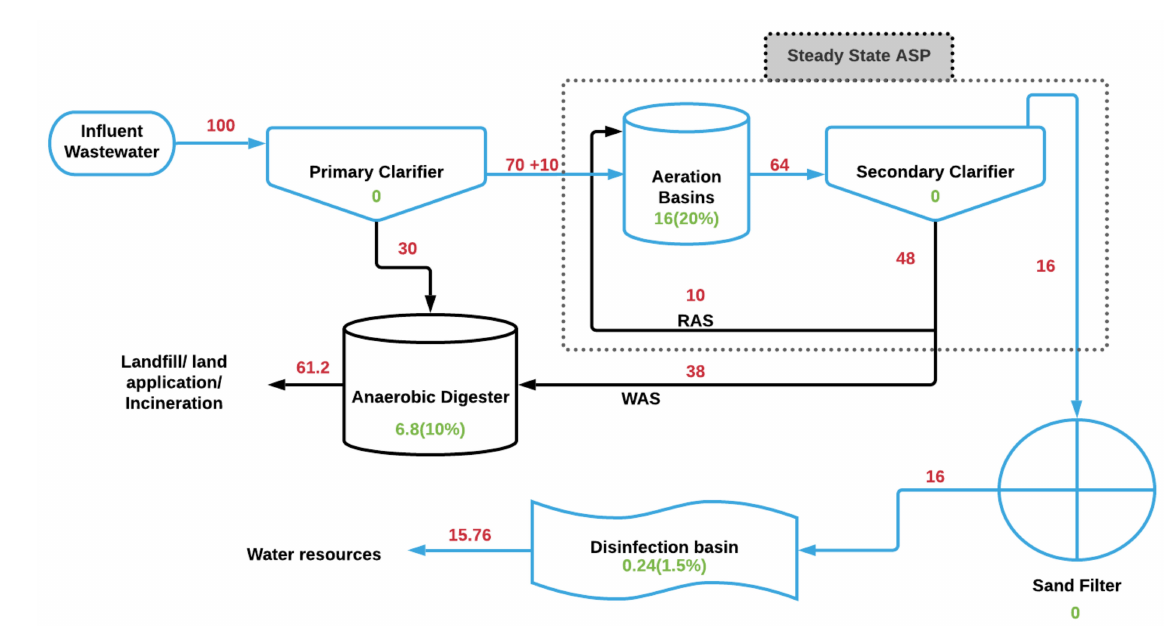
Figure 2. Mass balance of PVA in a conventional activated sludge treatment plant, considering clarifier efficiencies and biodegradation efficiencies. Numbers in red indicate the percentage of PVA in respective treatment streams, and numbers in green represent the amount (% absolute) of degraded PVA in respective sections. RAS and WAS represent return activated sludge and waste activated sludge, respectively. Numbers in parentheses represent the degradation efficiencies of respective